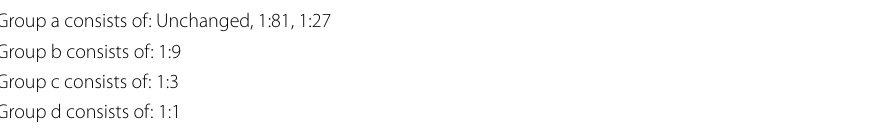
Table 23 HSD test groupings after ANOVA of AUPRC for the RUS factor